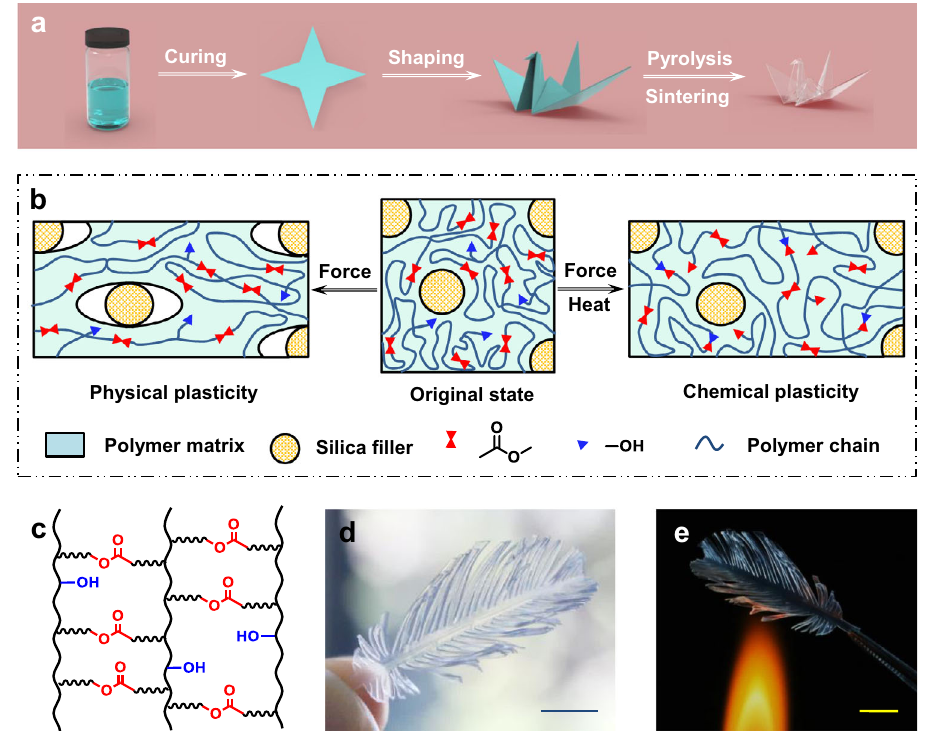
Fig. 1 Fabrication of 3D transparent origami glass. a Schematic illustration of the fabrication process. b Two mechanisms for permanent deformation via plasticity. c Dynamic polymer ester network with dangling hydroxyl groups. d Photographic image of a 3D transparent glass feather. Scale bar: 1 cm. e Demonstration of the high thermal resistance at 600 °C. Scale bar: 1